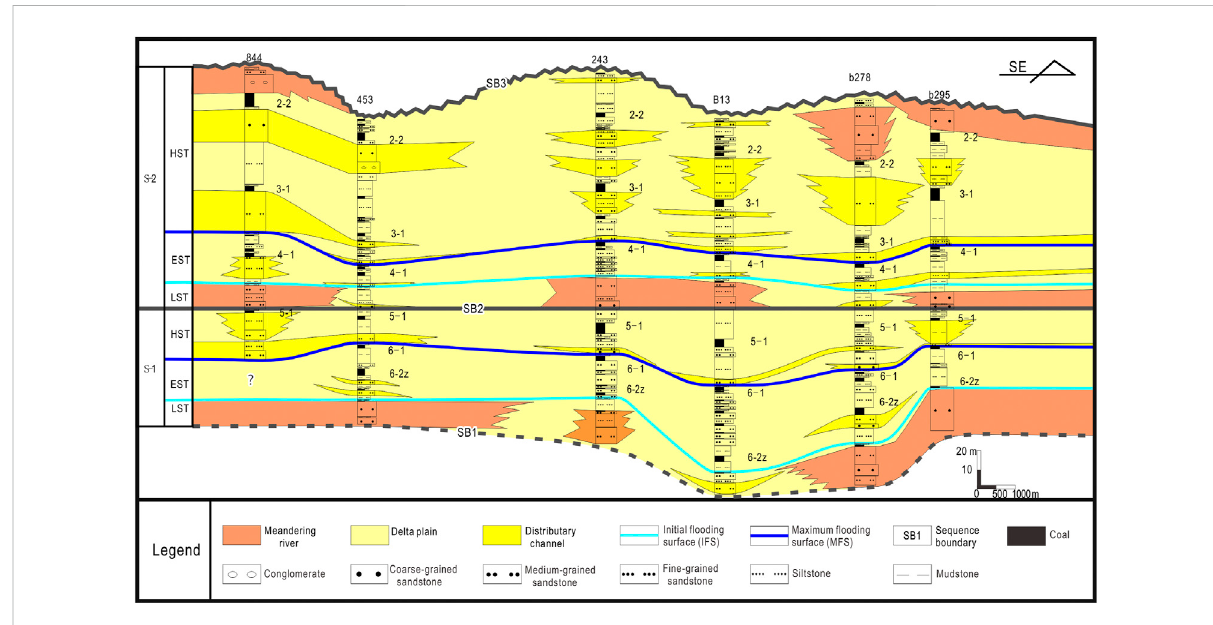
FIGURE 4 NW-SE cross-section (A-A ′ ) through the Yan ’ an Formation, showing lithofacies, interpreted depositional environments (including coal seams) andsequence-stratigraphicdata.TheintraformationalsequenceboundarySB2istakenashorizontal.SeeFigure1Bforlocationofthecross-section.